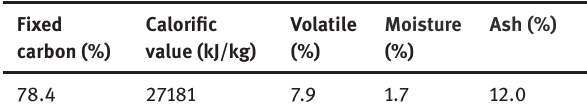
Table 2: Industrial analysis results of WG (Wugang, i.e., Wuhan iron and steel)